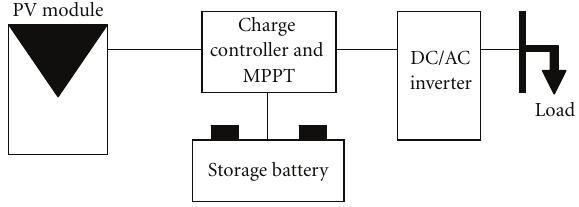
Figure 8: Typical standalone PV system